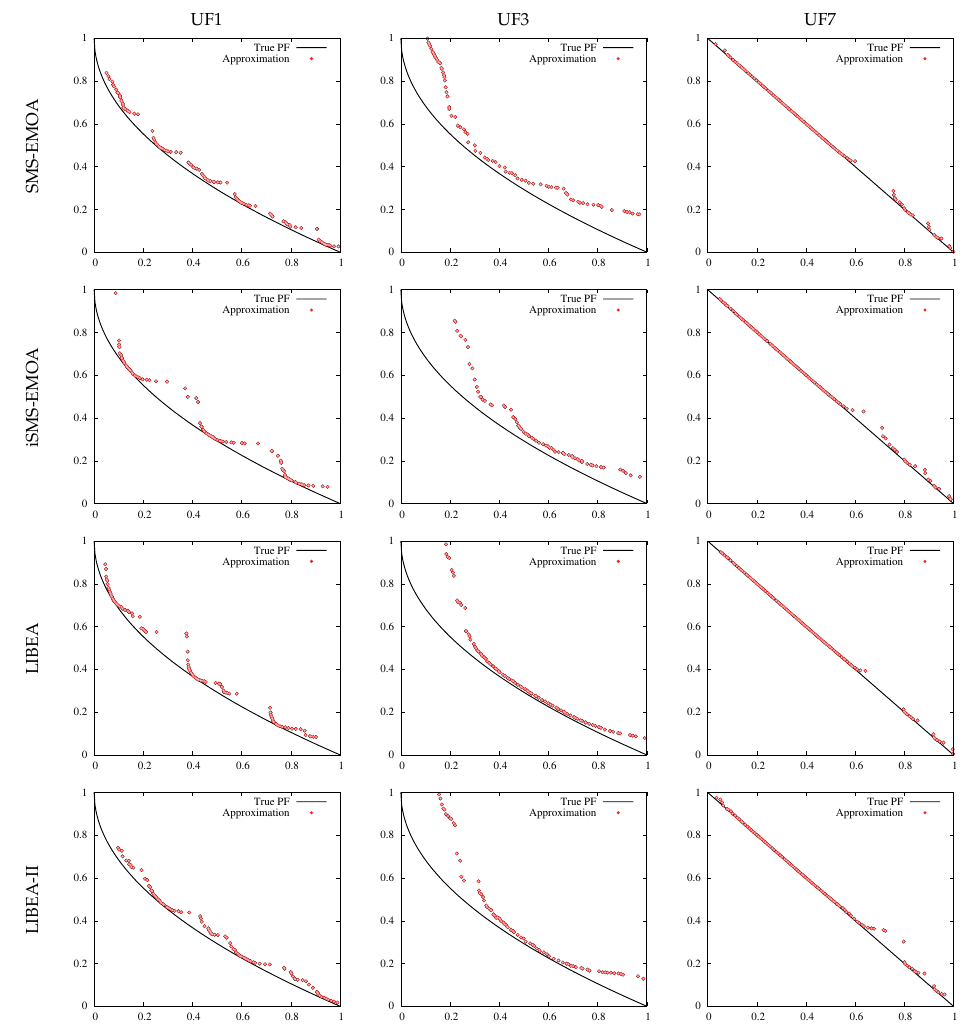
Figure 3. Non-dominated solutions found by the four algorithms under study to the test problems UF1, UF3, and